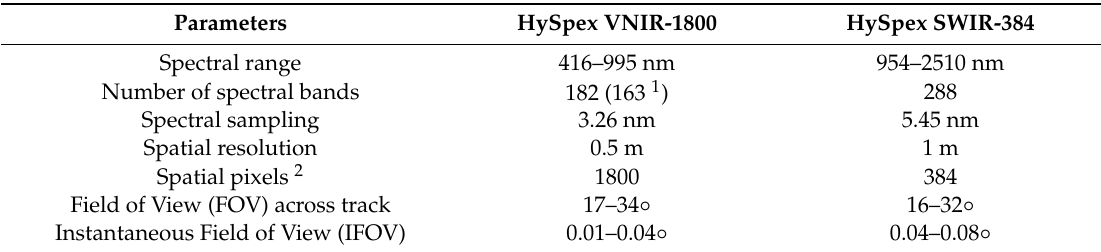
Table 1. Main technical characteristics of HySpex scanners used in this work.